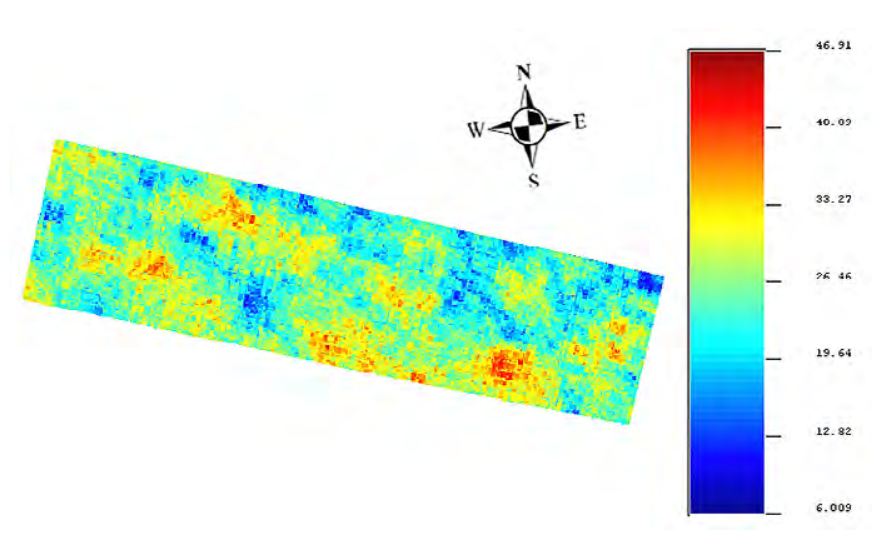
Figure 8f. SP Realization Example #6